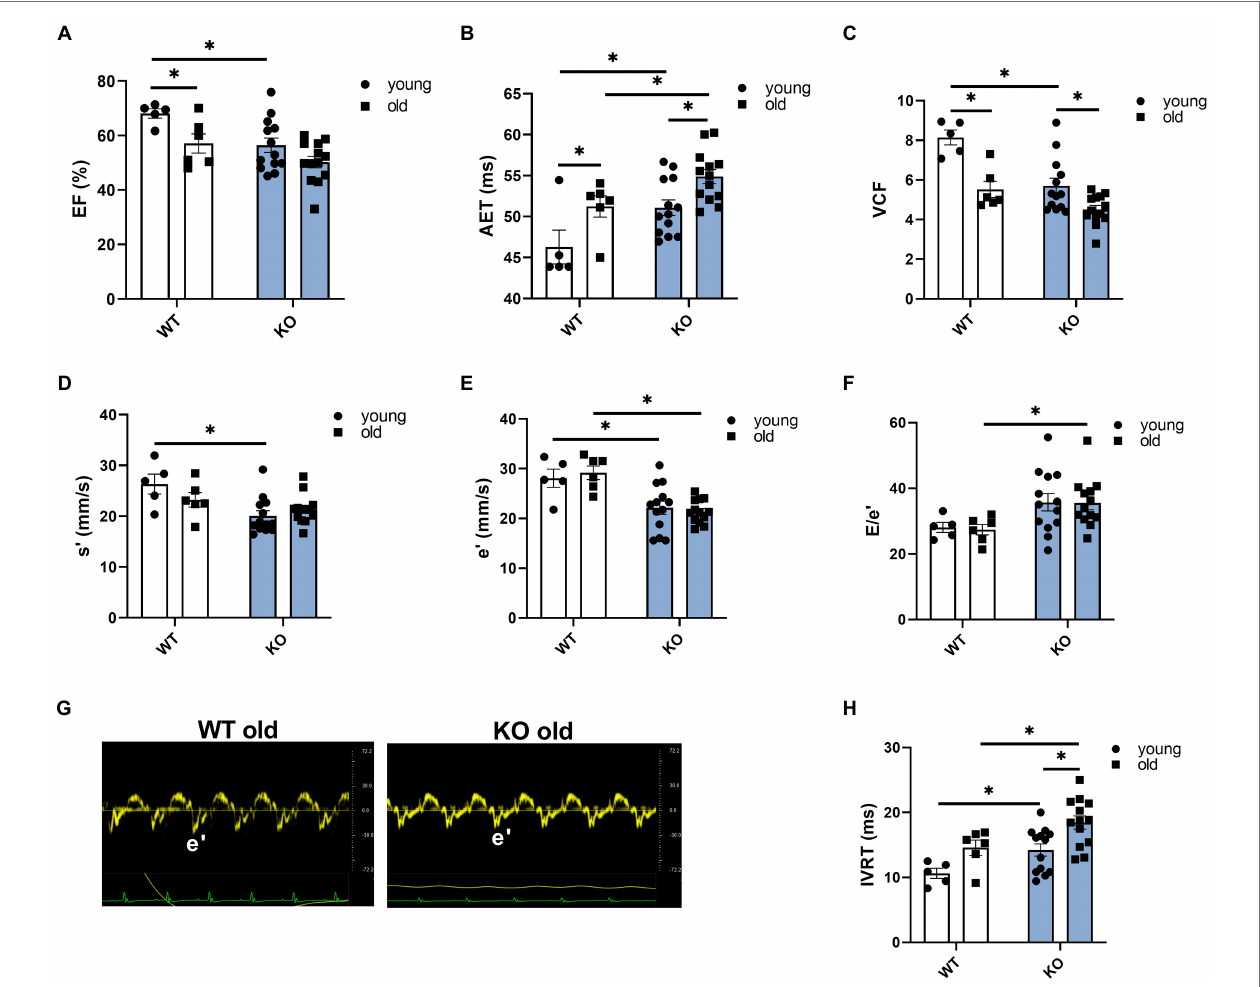
FIGURE 2 | Deletion of β -arrestin-2 signaling causes impaired systolic and diastolic function in aged mice. (A) All mice show ejection fraction (EF) ≥ 50%. (B) Aortic ejection time is prolonged in aged KO. (C) Circumferential fiber shortening velocity calculated as minor axis shortening/ejection time is slower in aged KO mice. (D) KO mice show decreased peak myocardial contraction velocity, s ′ . (E) Young and old KO mice show slower peak myocardial relaxation velocity, e ′ . (F) Aged KO mice show increased peak blood inflow velocity E/e ′ ratio. (G) Sample tissue Doppler traces show slower myocardial relaxation velocity (e ′ ) in aged KO mice. (H) Aged KO mice show prolonged isovolumetric relaxation time. Young: 3–6 months and old: 12–16 months. N = 5–13. Data presented as mean ± SEM. Outliers were identified with the ROUT method and excluded from analyses. Data analyzed with a two-way ANOVA post-hoc Fisher’s LSD test. * p <